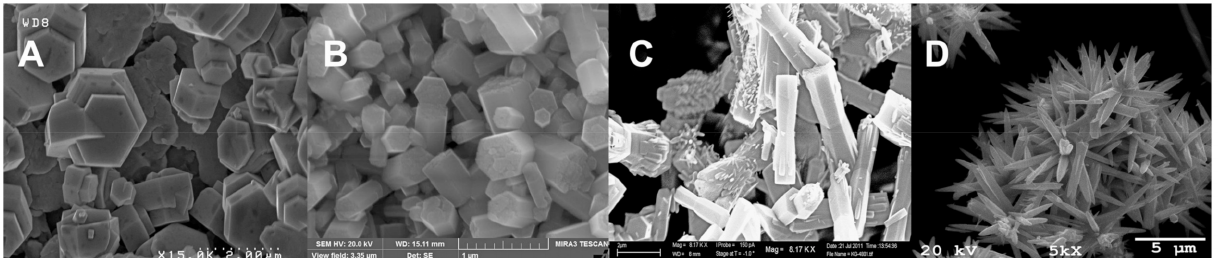
Figure 1. SEM images of ZnO powders prepared from [Zn(acetate) 2 (amine) x ] precursors at 95 ◦ C in an aqueous solution. The precursors used were ( A ) [Zn(acetate) 2 (Tris) 2 ], ( B ) [Zn(acetate) 2 (2-